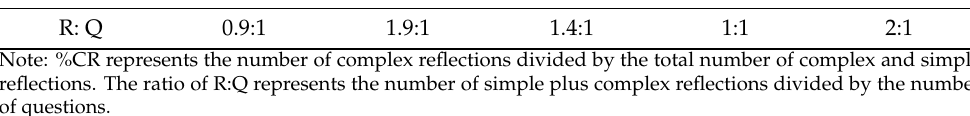
Table 2. Frequency table changes in drug use and abstinence at 3-month follow-up ( N = 20).